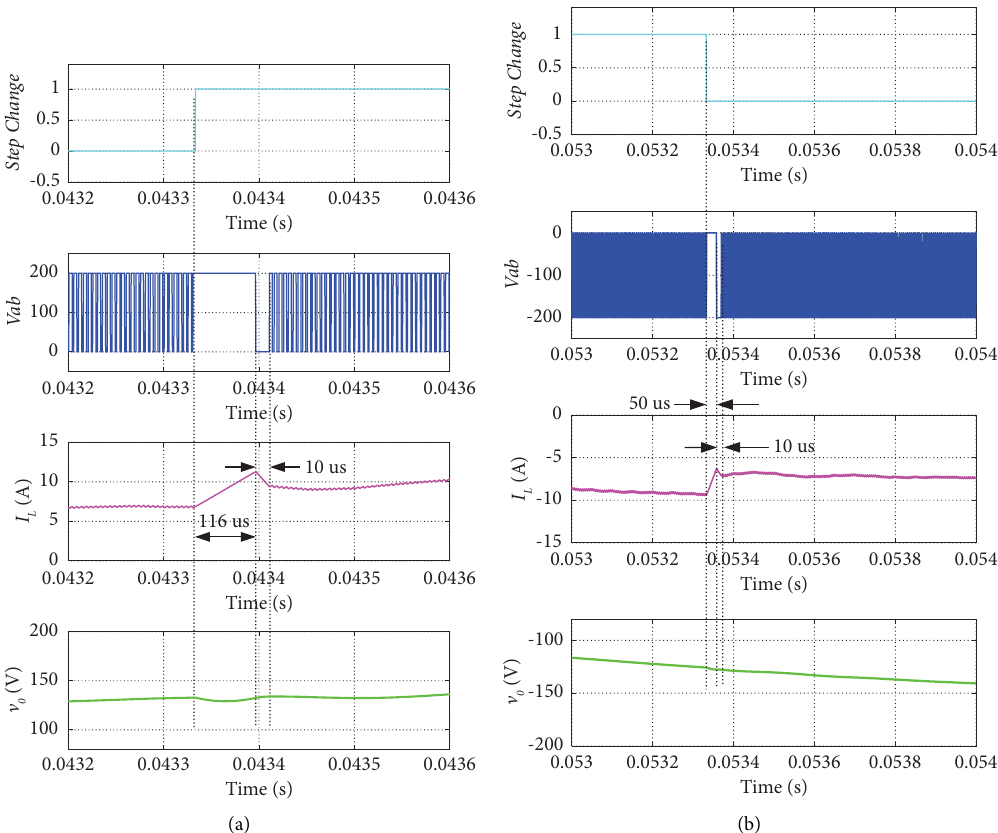
Figure 12: Transient response with on-line trajectory control. (a) Step up from 7.8 A to 10.5 A at π /3. (b) Step-down from 10.5 A to 7.8 at 4 π /3.